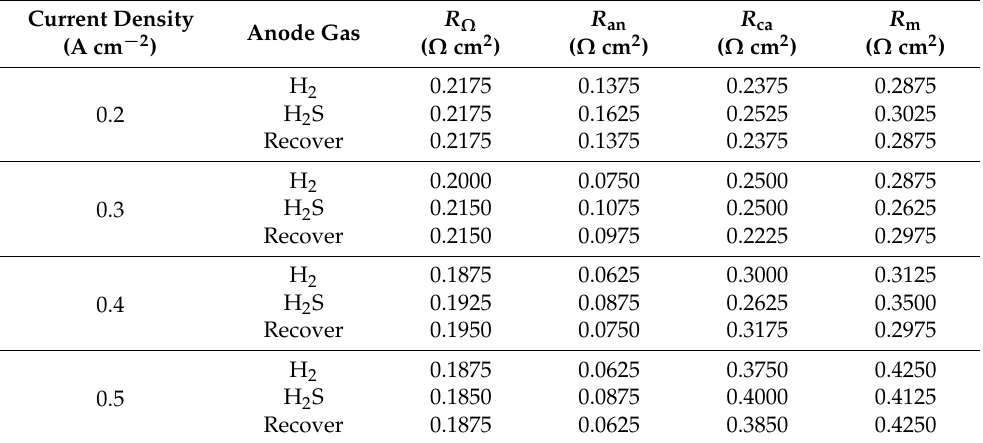
Table 2. Fitted resistances of MEAs operated at various current density levels under different gases.